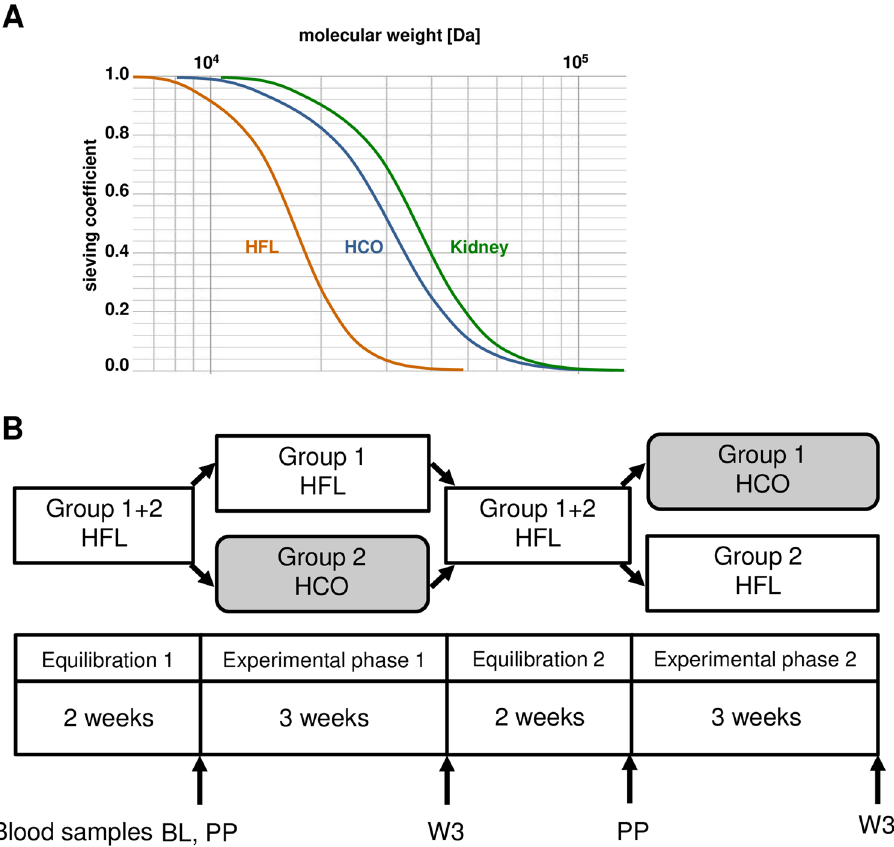
Figure 1. Clinical trial comparing HFL with HCO dialysis membranes. ( A ) Scheme showing the elimination characteristics of HFL and HCO membranes in comparison to healthy kidneys with sieving coefficient plotted against molecular weight. ( B ) Cross over-design of the randomized study with 2 cycles of equilibration and experimental phases. BL: Baseline blood samples for clinical chemistry drawn pre-dialysis at the first dialysis session of experimental phase 1. PP: Experimental blood samples drawn pre- and post-dialysis at the first dialysis session of experimental phases 1 and 2. W3: Experimental blood samples drawn pre-dialysis at the first dialysis session after completion of the 3-week experimental phases 1 and